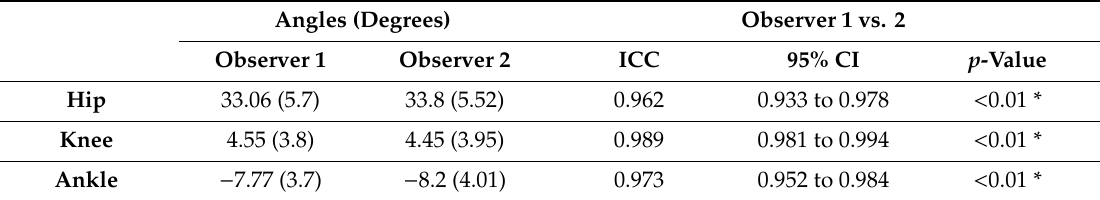
Table 2. Inter-rater reliability of the Kinovea parameters.